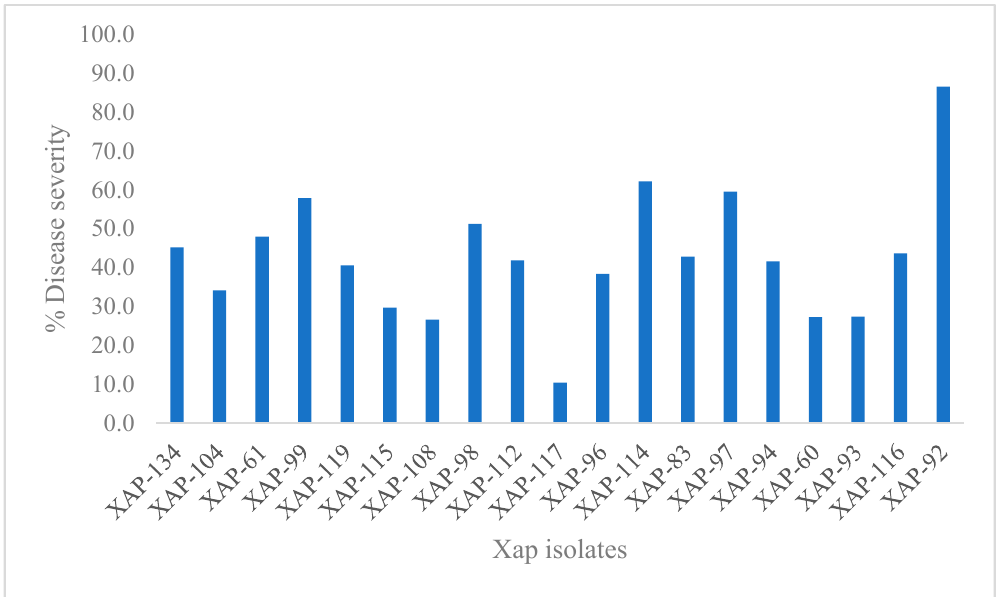
Figure 2. Percentage of disease severity (% DS) caused by different Xap isolates ( n = 22) on healthy Bhagwa pomegranate plants under greenhouse conditions.